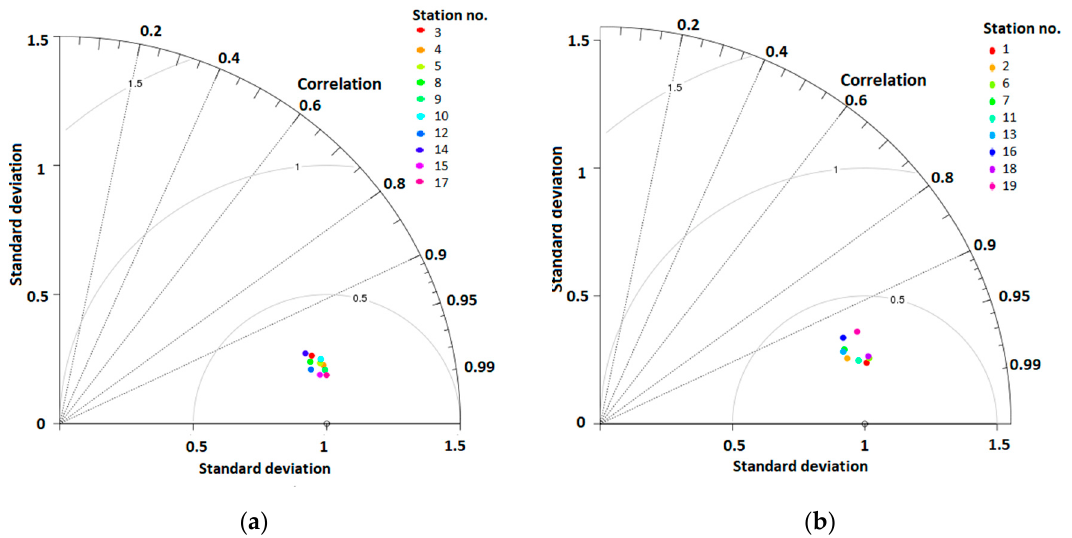
Figure 5. Taylor diagram for forecast air temperature for ( a ) mountain and hill peaks and ( b ) valley bottoms for the period 1 September to 31 December 2017.